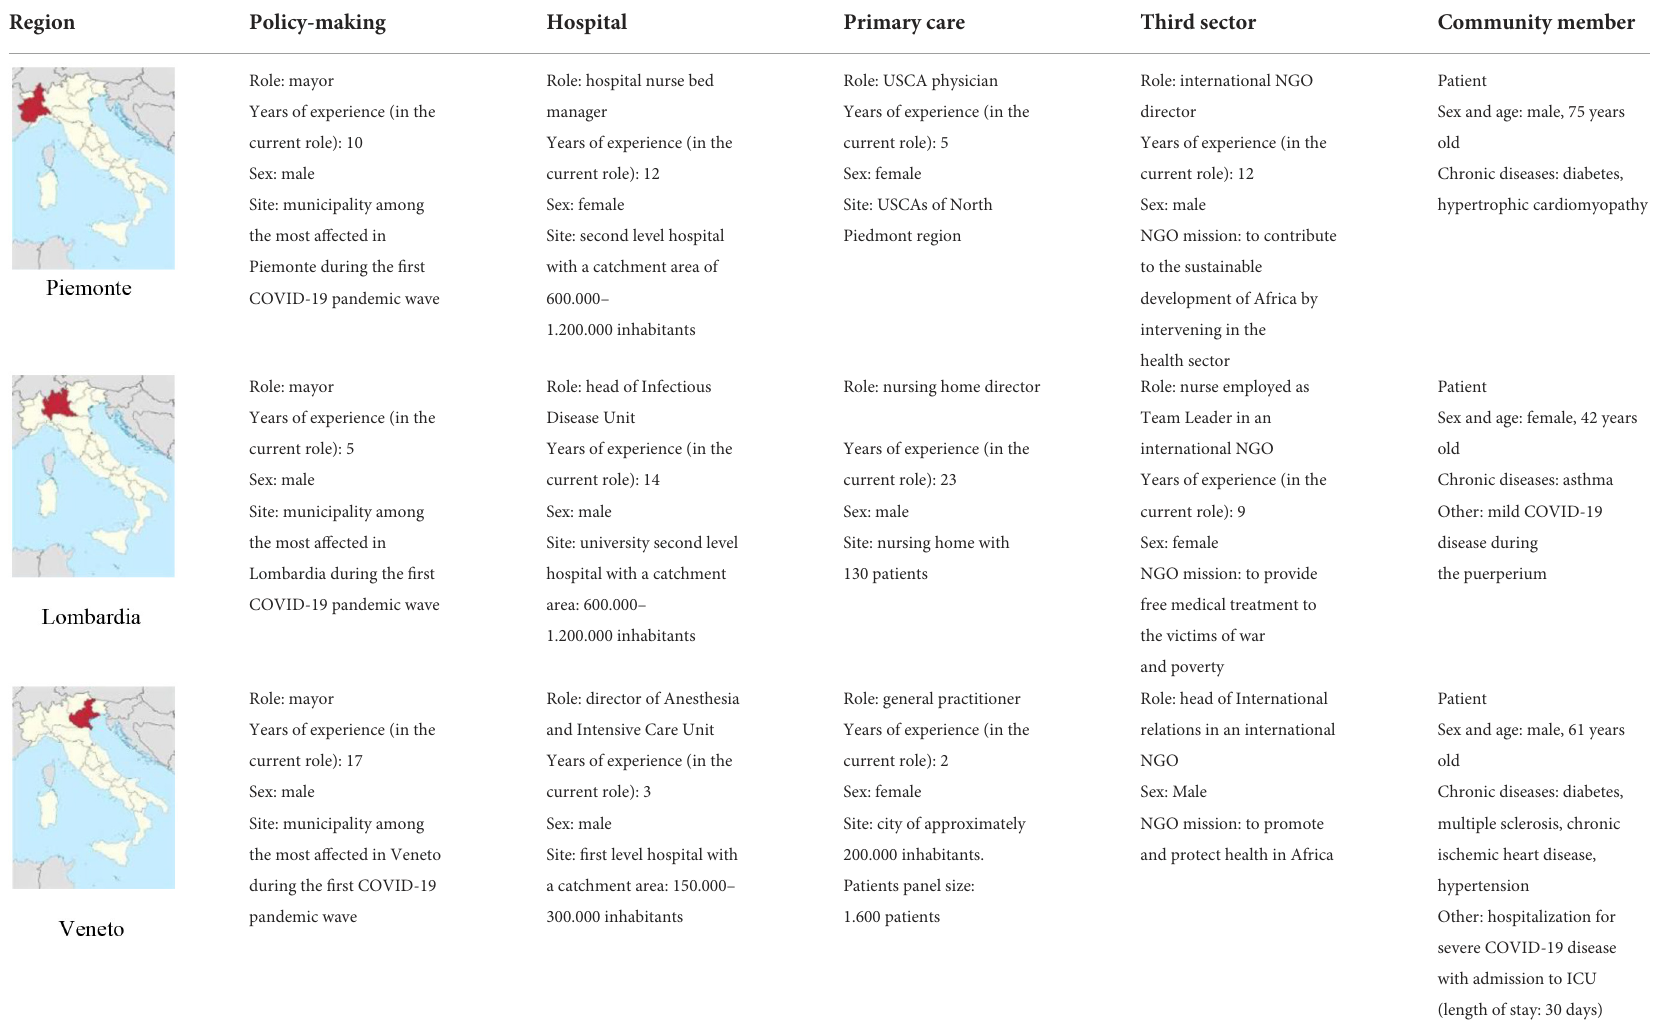
TABLE 1 Demographic information for interview participants (ICU, Intensive Care Unit; NGO, Non-Governmental Organization; USCA, Special unit for continuity of care). Region Policy-making Hospital Primary care Third sector Community